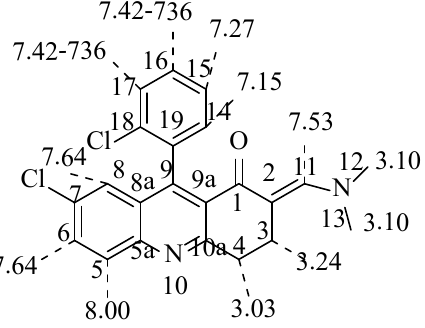
Figure 1: Summary of Proton d Values of 3c.